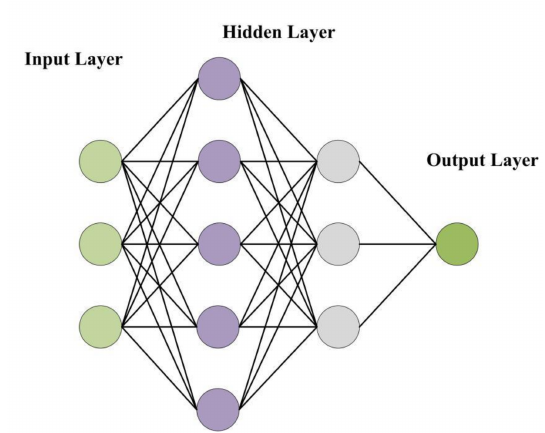
Figure 1. The network structure of multi-layer perceptron